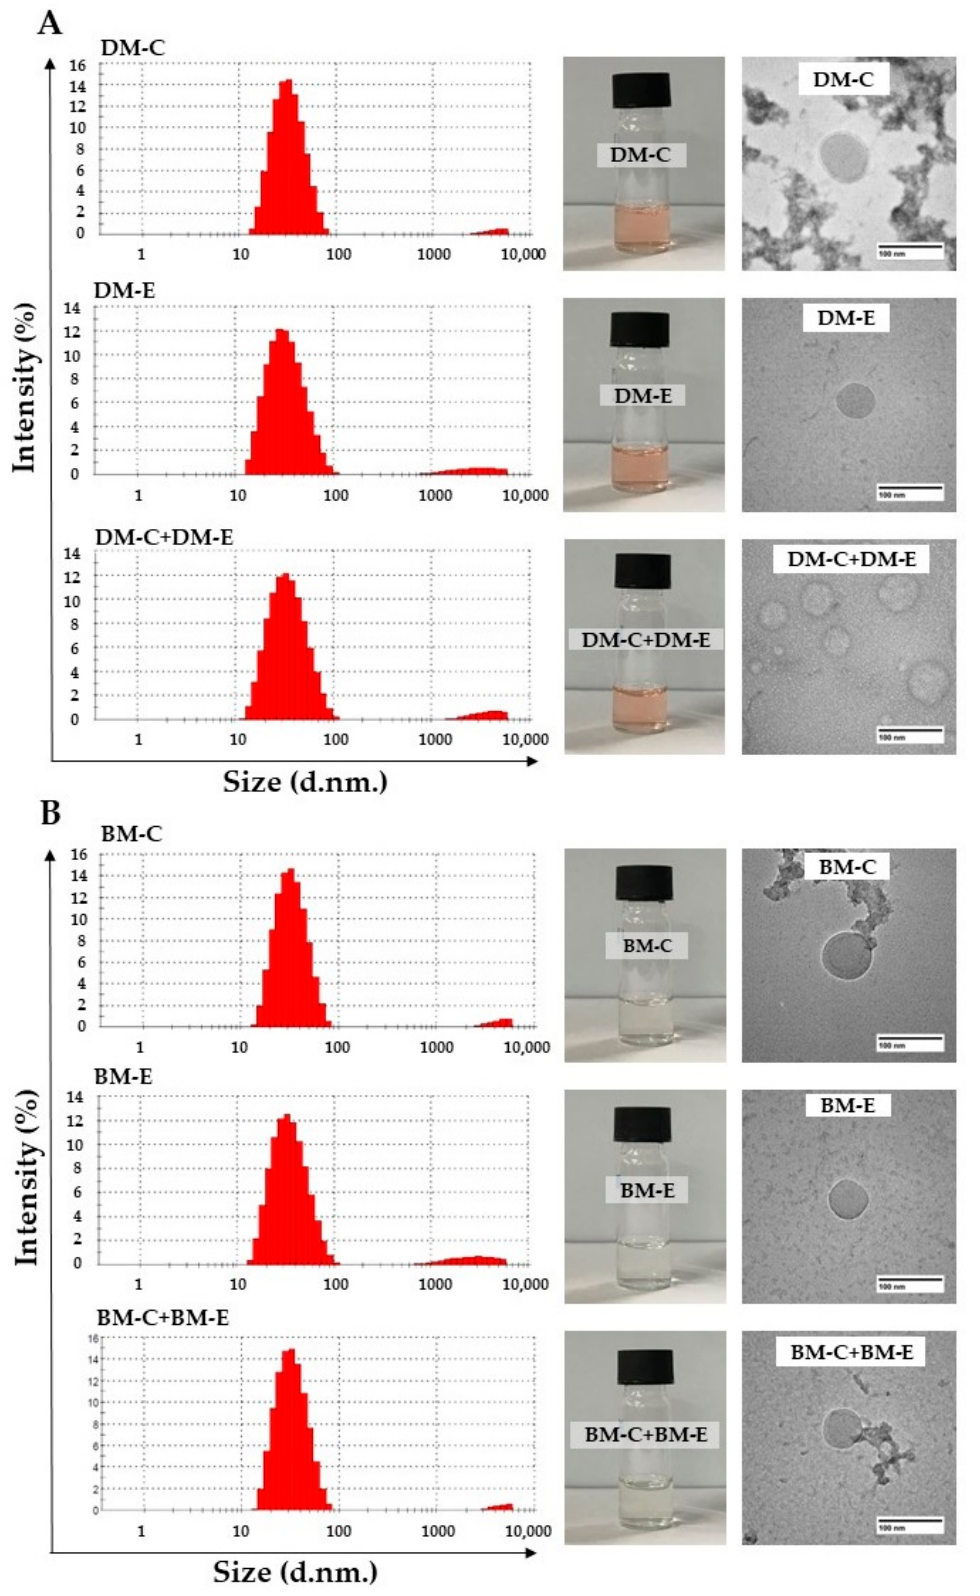
Figure 9. Particle size distribution histogram using DLS, physical appearance, and morphology from TEM of ( A ) BM conjugated FLT3 peptides (BM-CKR, BM-EVQ, and BM-CKR+BM-EVQ) and ( B ) DM conjugated FLT3 peptides (DM-CKR, DM-EVQ, and DM-CKR+DM-EVQ).